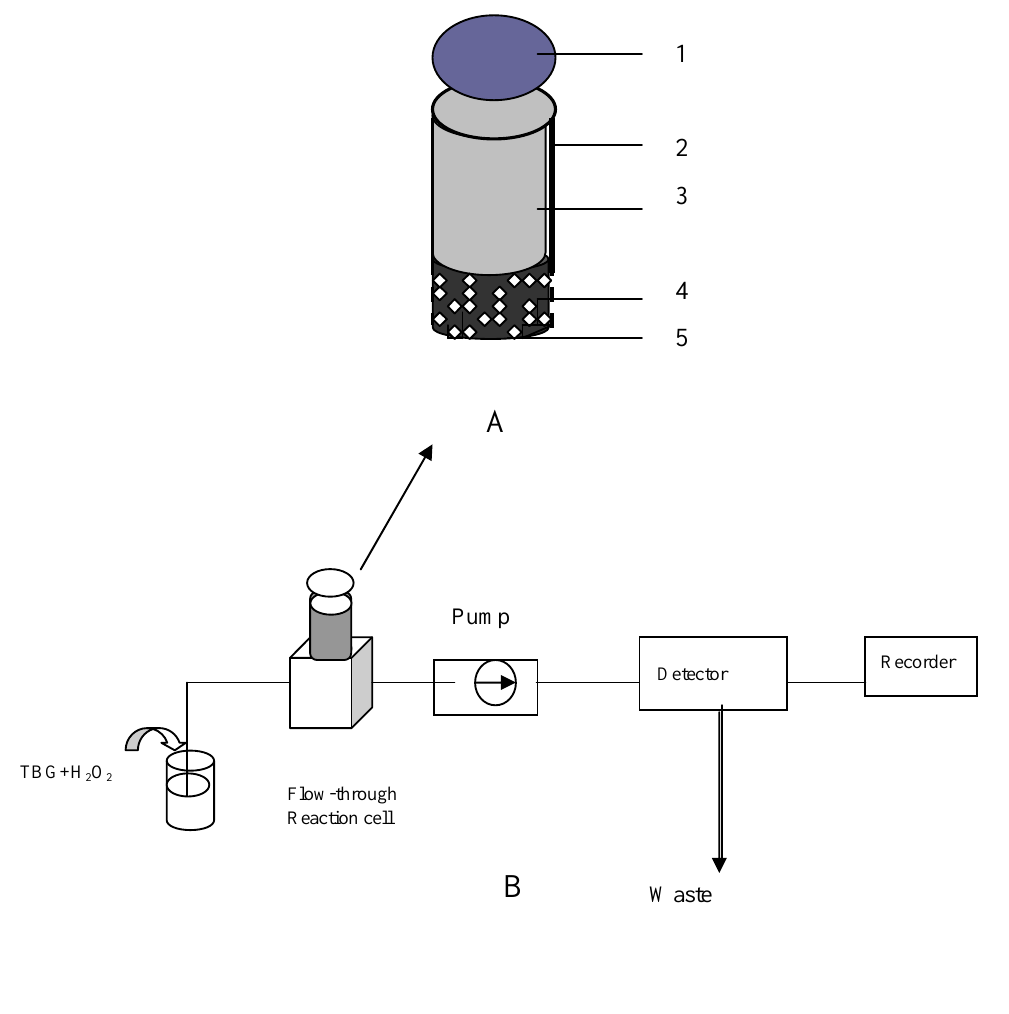
Figure 2. A: Configuration of the BrAg-based immunosensing device. (1) PVC nut, (2) PVC tube, (3) PVC screw, (4) BrAg-paraffix-graphite matrix, (5) entrapped BrAg. B: Schematic diagram of flow injection system coupling with